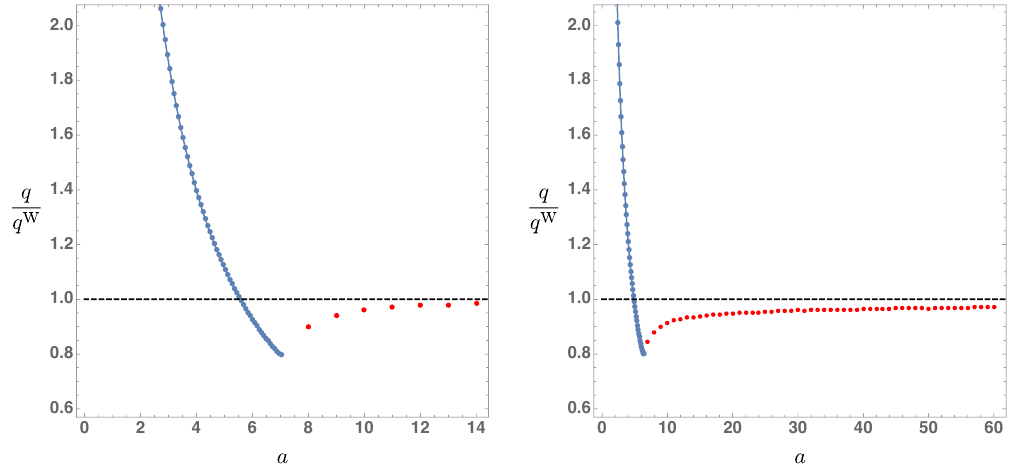
Figure 5 . For (cid:11) < 1, the bound on q= (cid:1) needed to preserve cosmic censorship is precisely the weak gravity bound: the blue solid line indicates the onset of solutions with (cid:8) 6 = 0, and the red dots show the approximate location of singular solutions. On the left plot we have (cid:11) = 1 = right (cid:11) = 0 : 9. Notice the di(cid:11)erent scale on the horizontal axes. In both cases, (cid:1) =